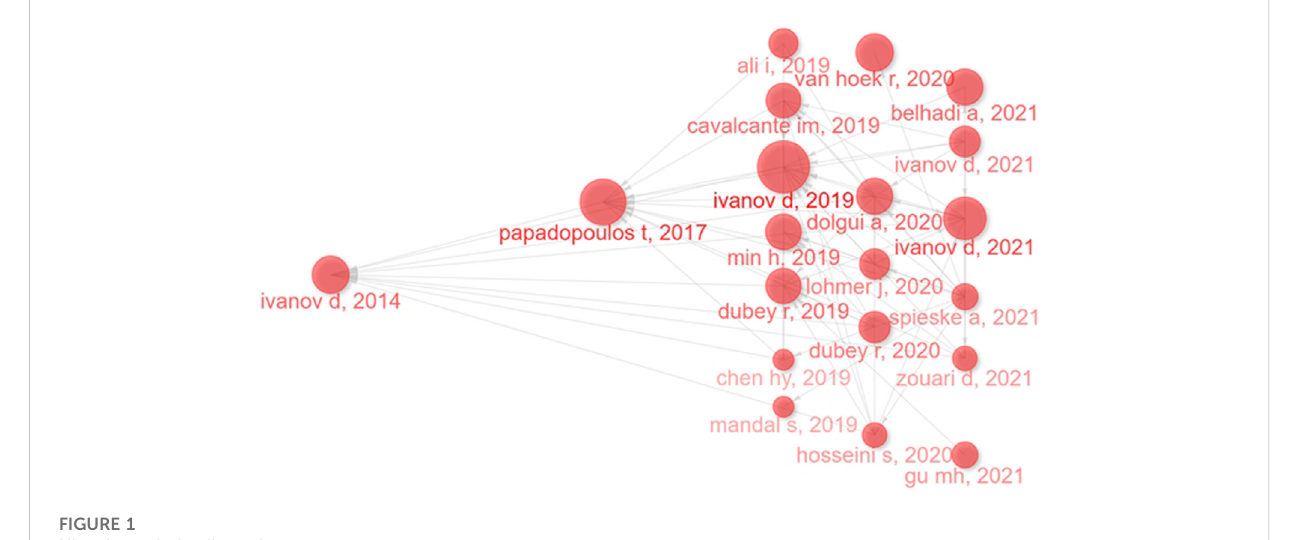
FIGURE 1 Historiograph: intellectual